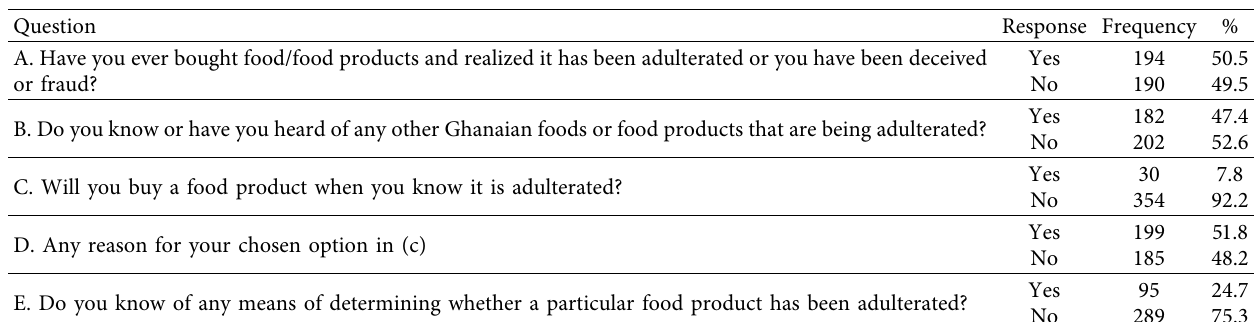
Table 3: Knowledge of respondents regarding food